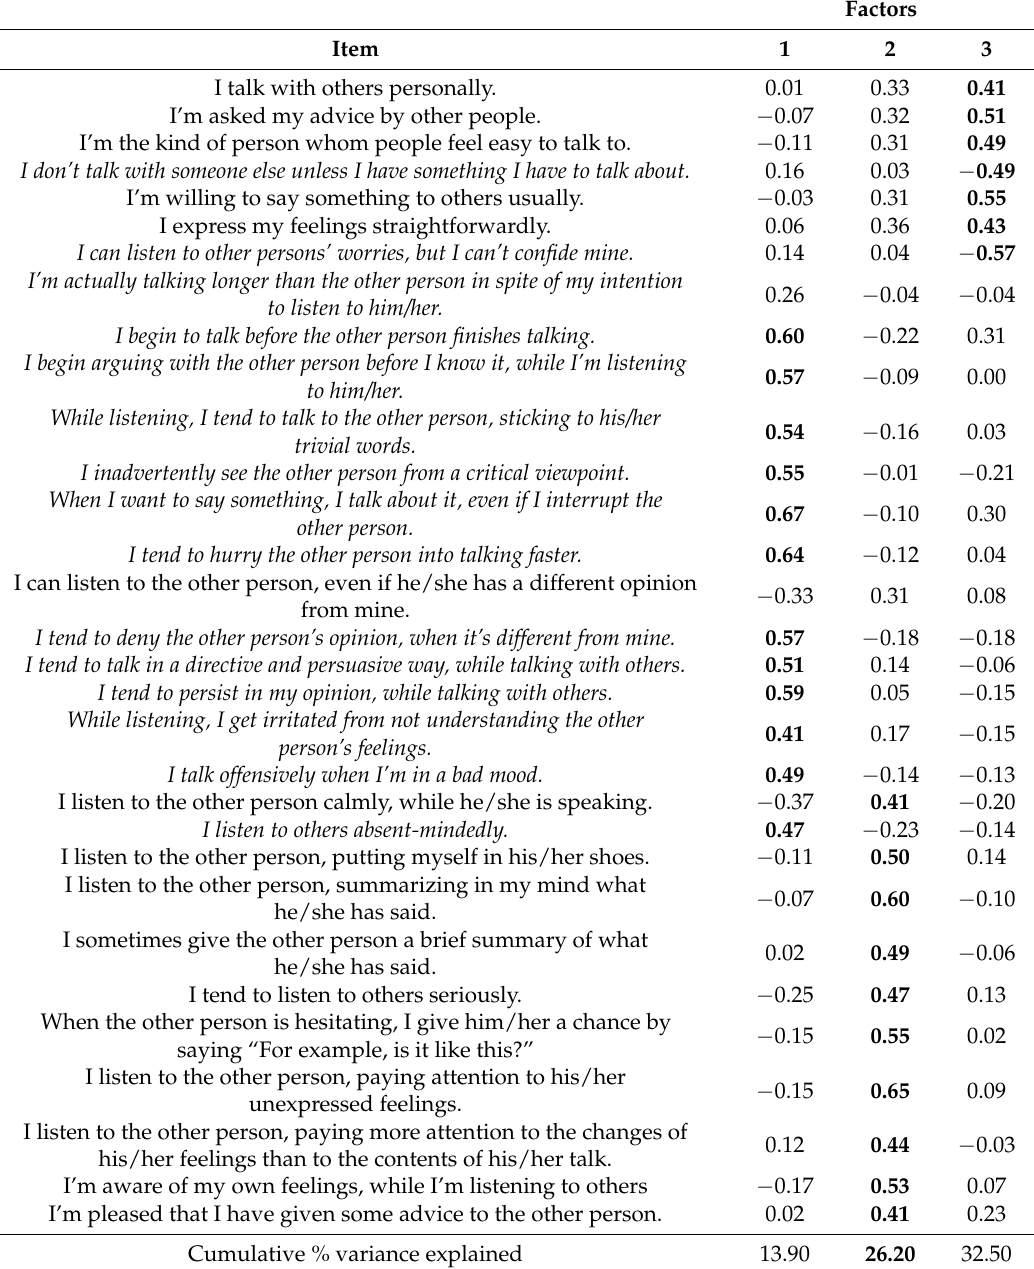
Table 2. Factor loadings from the results of exploratory factor analysis for the ALAS.